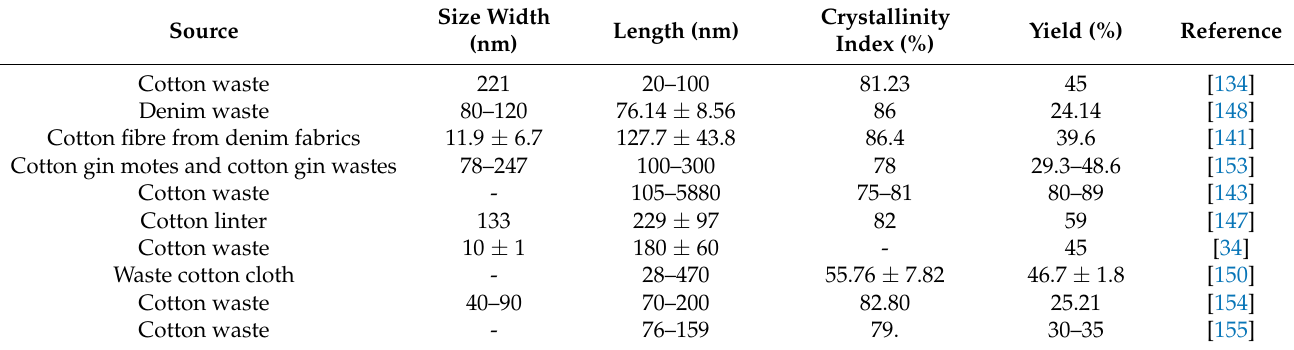
Table 5. Comparative study of material properties of cellulose nanocrystals obtained from cotton